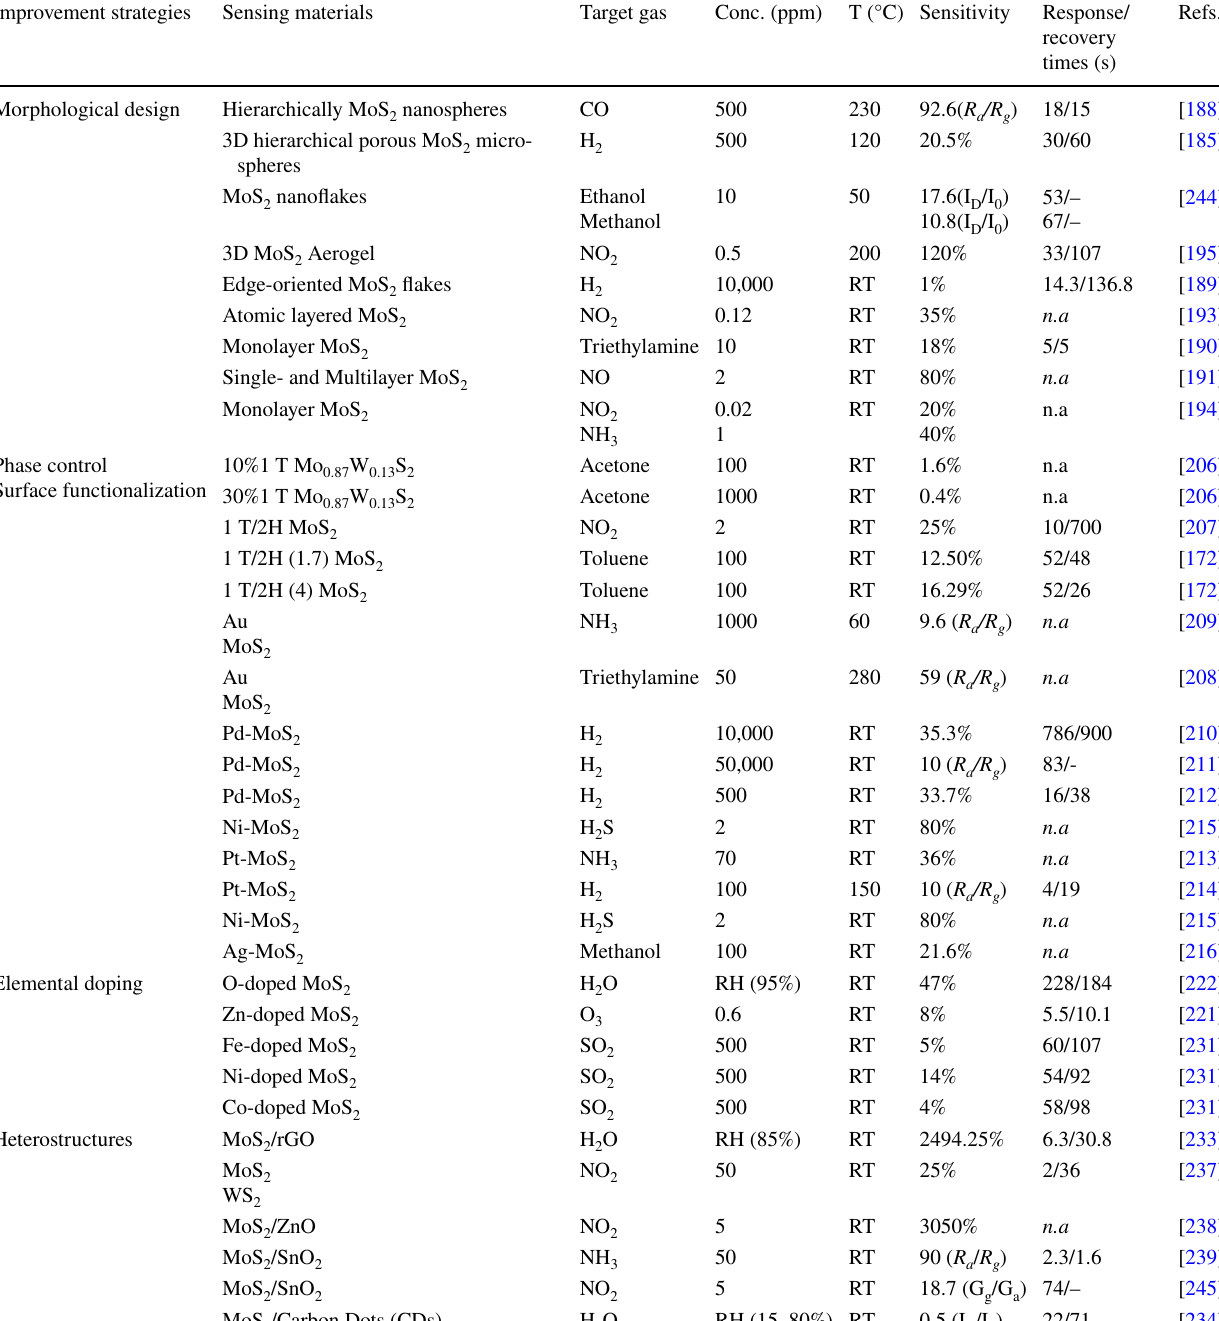
Table 2 Improvement strategies of MoS 2 -based gas sensor